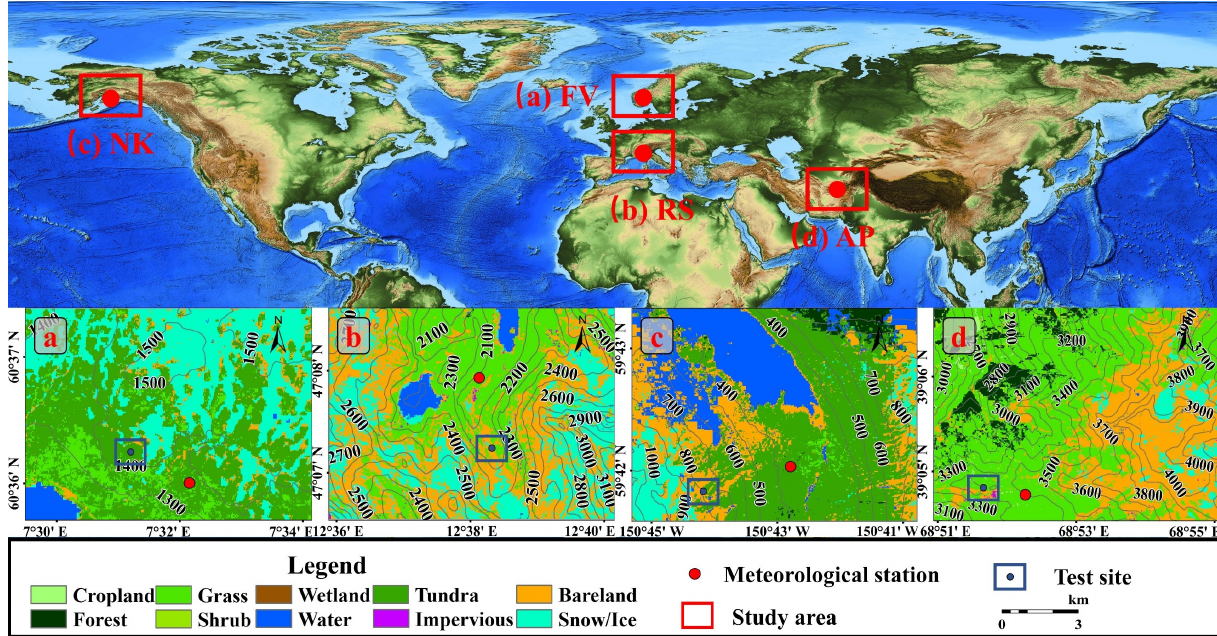
Figure 1. Land-cover types—derived from the Finer Resolution Observation and Monitoring of Global Land Cover (FROM-GLC10) data product—and contour distribution of four typical thick snow study areas located in the Northern Hemisphere: ( a ) FV; ( b ) RS; ( c ) NK; ( d ) AP. The locations of the meteorological stations and test sites (used for correlation analysis) are also shown for each study area. The global distribution of the location of each study area is shown in the background map (provided by NOAA’s ETOPO1 data).